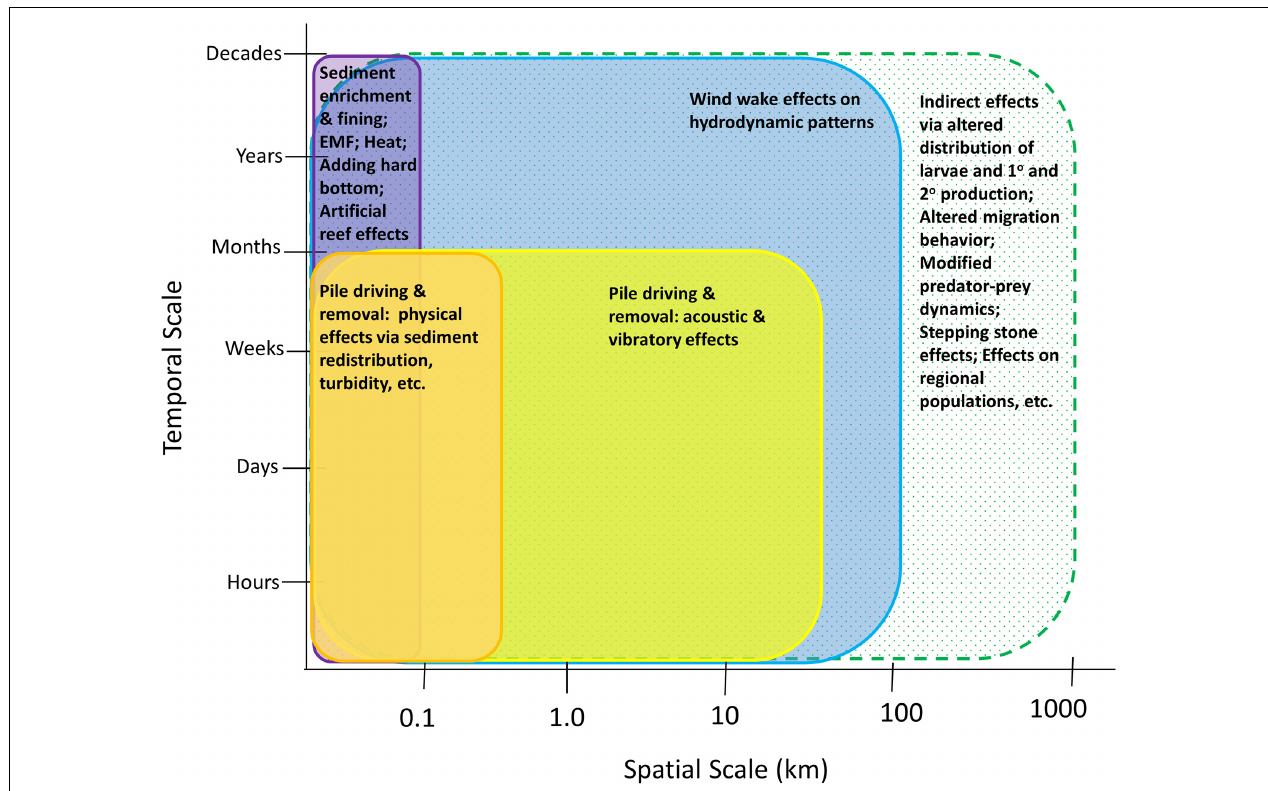
FIGURE 2 | Hypothesized spatial and temporal scales of IPFs that may affect fisheries resource species during the construction and operation phases. Solid bars indicate IPFs and their effects; the hatched bar indicates the potential scales of indirect